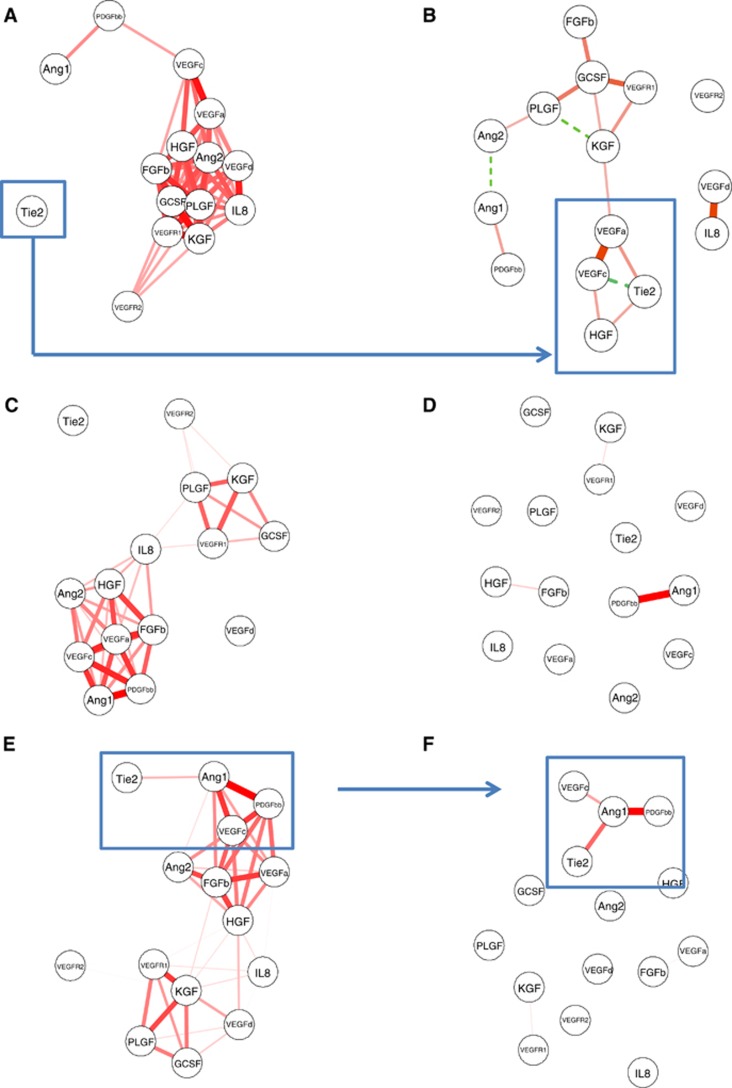
Analysis of correlation networks.(A) Pearson's correlation network for all patients pre-treatment. (B) Partial correlation network for all patients pre-treatment. (C) Pearson's correlation network for patients on the standard arm, during treatment. (D) Partial correlation network for patients on the standard arm, during treatment. (E) Pearson's correlation network for patients on the experimental arm, during treatment. (F) Partial correlation network for patients on the experimental arm, during treatment. Pearson's correlation networks were plotted on the left panel (A, C, E) and partial correlation networks were plotted on the right (B, D, F). Each row of plots, from top to bottom, demonstrated the correlation networks for patients at baseline, on standard arm during treatment and on experimental arm during treatment, respectively. Each node in the networks represents one angio-biomarker. The thickness of the edge between two nodes represents the strength of correlation. Positive correlations are red solid lines and negative correlations, green dashed lines. Correlations with absolute values smaller than 0.3 were not displayed. The thickest line represents a maximum correlation of 0.74 while the median correlation shown in the networks is 0.55. Angio-biomarkers are highlighted if they demonstrate significant changes in correlation.